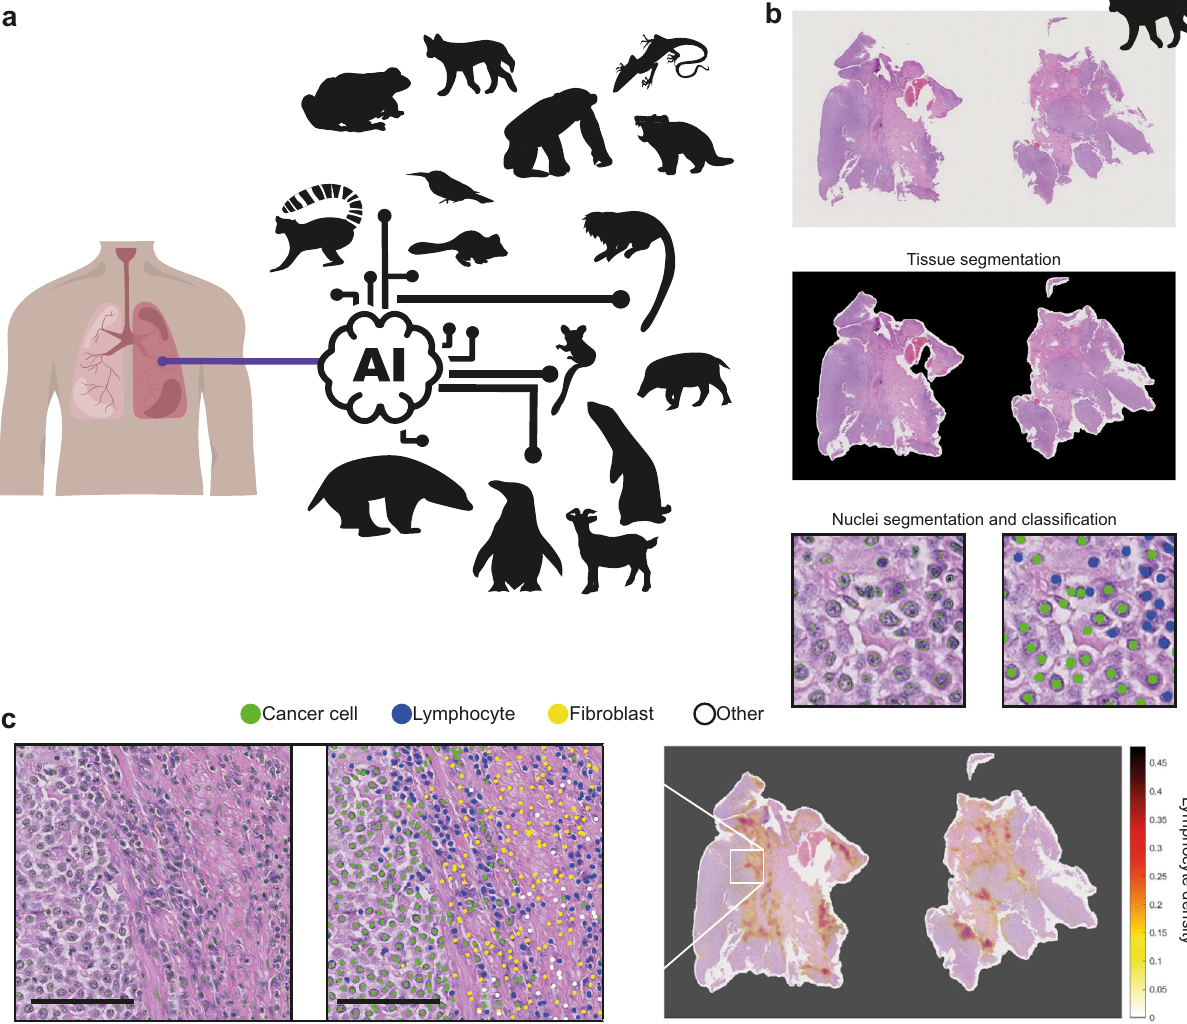
Fig. 1 | Pan-species computational pathology. a Transfer learning of cell identi fi cation from human lung to pan-species tumour pathology. b, c Over- view of the H&E single-cell analysis pipeline as illustrated using a dog ’ s (CANFAM) transmissible venereal tumour sample. b This AI pipeline 35 fi rst segments the viable tissue area, then detects and classi fi es allcells into cancer, stromal, lymphocyte and others. For more details, see Methods. c The pipeline is implemented to spatially pro fi le the immune microenvironment at the